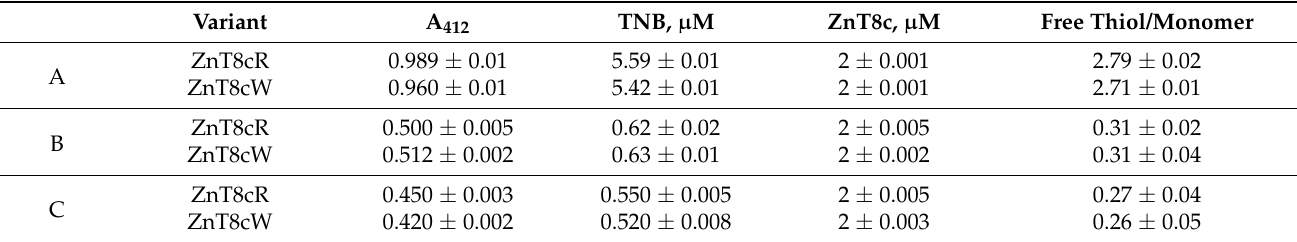
Table 4. Assaying the sulfhydryls in ZnT8c variants with 5,5 (cid:48) -dithio-bis-(2-nitrobenzoic acid) (DTNB). (A) Free sulfhydryls (thiols) per ZnT8c monomers; (B) Free sulfhydryls (thiols) per ZnT8c monomers after incubating proteins with 15 mM iodoacetamide; (C) Free sulfhydryls (thiols) per ZnT8c monomers after incubating proteins with 15 mM hydrogen peroxide. The experiments were performed in triplicate.